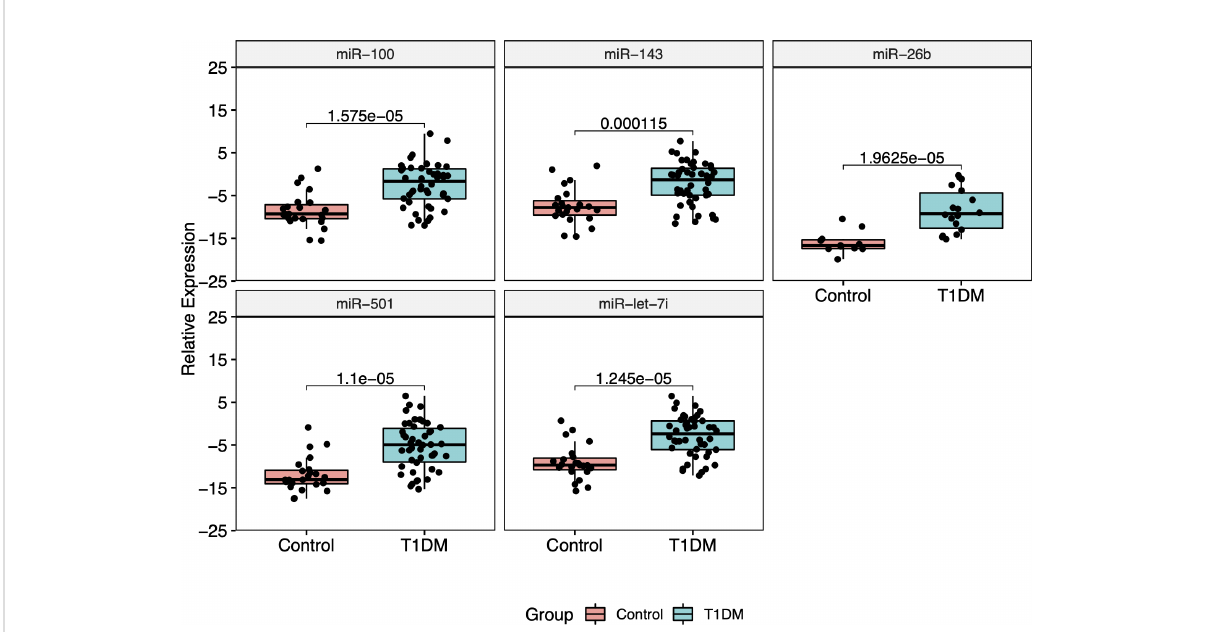
FIGURE 5 Relative expression of fi ve RT-qPCR validated miRNAs. All of them showed to be upregulated in T1DM